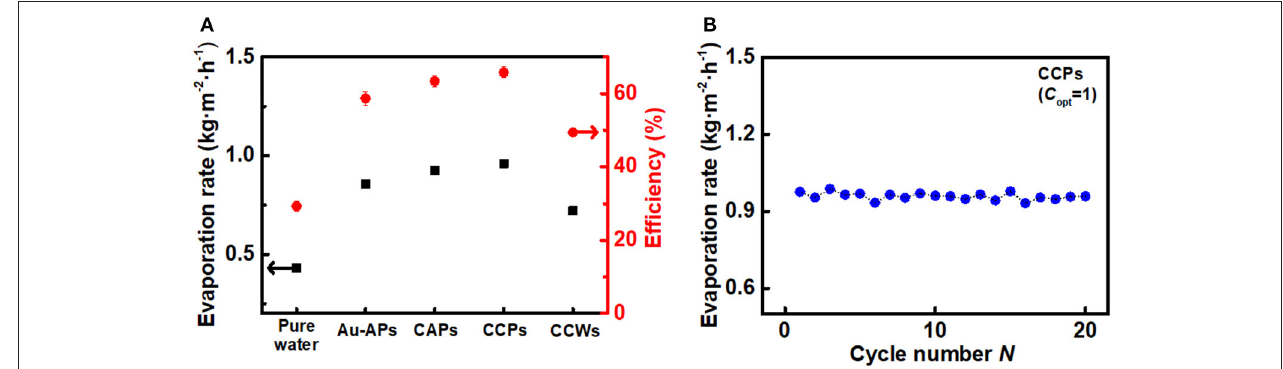
FIGURE 5 | (A) The average evaporation rates (left-hand side axis) with pure water, Au-APs, CAPs, CCPs, and CCWs (black square points) under the solar illumination of 1 sun, together with the corresponding η ECE of pure water, Au-APs, CAPs, CCPs, and CCWs (red circular points, right-hand side axis). (B) The recyclability of CCPs under 1 sun illumination by recycling 20 times. Each cycle was tested for